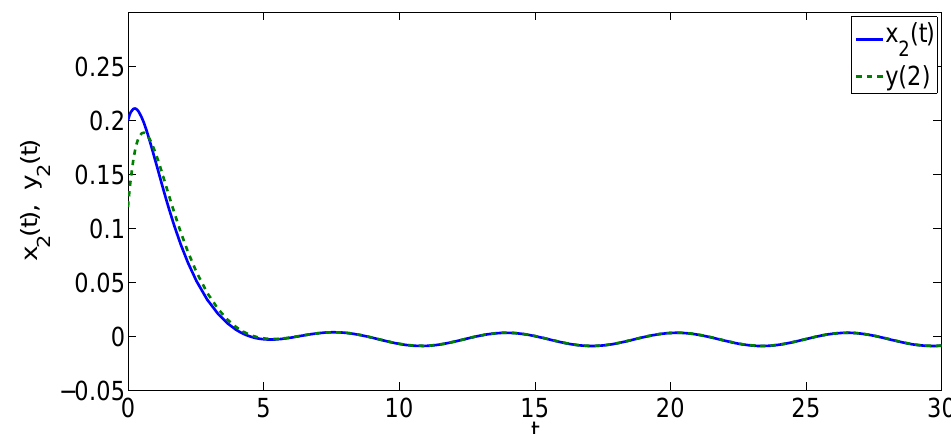
Figure 2. The synchronization trajectories between the state x 2 ( t ) of the drive system in Equation (30) and the state y 2 ( t ) of the response system in Equation (31) in Example 1.